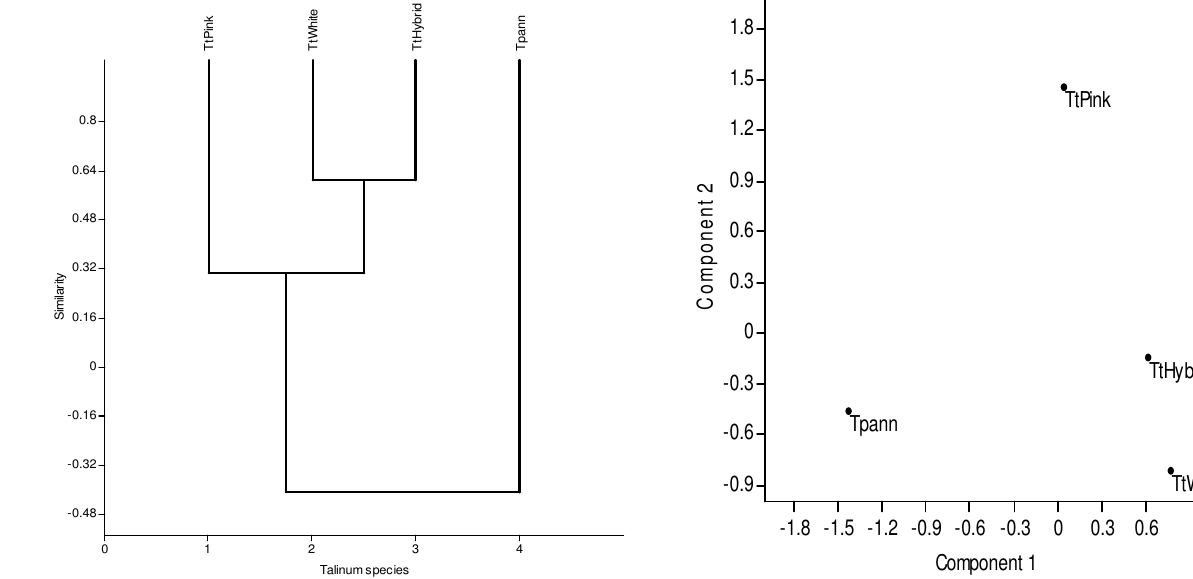
Fig. 2. Principal Component Analysis showing the relationship of Talinum taxa based on ten quantitative and qualitative pollen characters. Legend: TtPink – Talinum triangulare Pink Petals; TtWhite - Talinum triangulare White Petals; TtHybrid - Talinum triangulare Pink and White Petals F1 Hybrid; Tpann - Talinum paniculatum T . triangulare pink petals